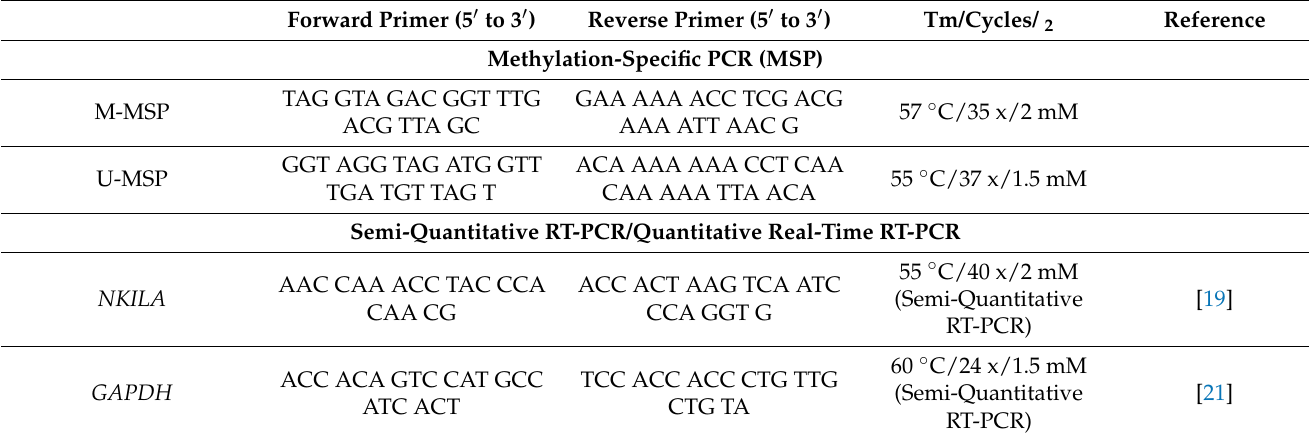
Table 1. Primer sequences and PCR reaction conditions for NKILA